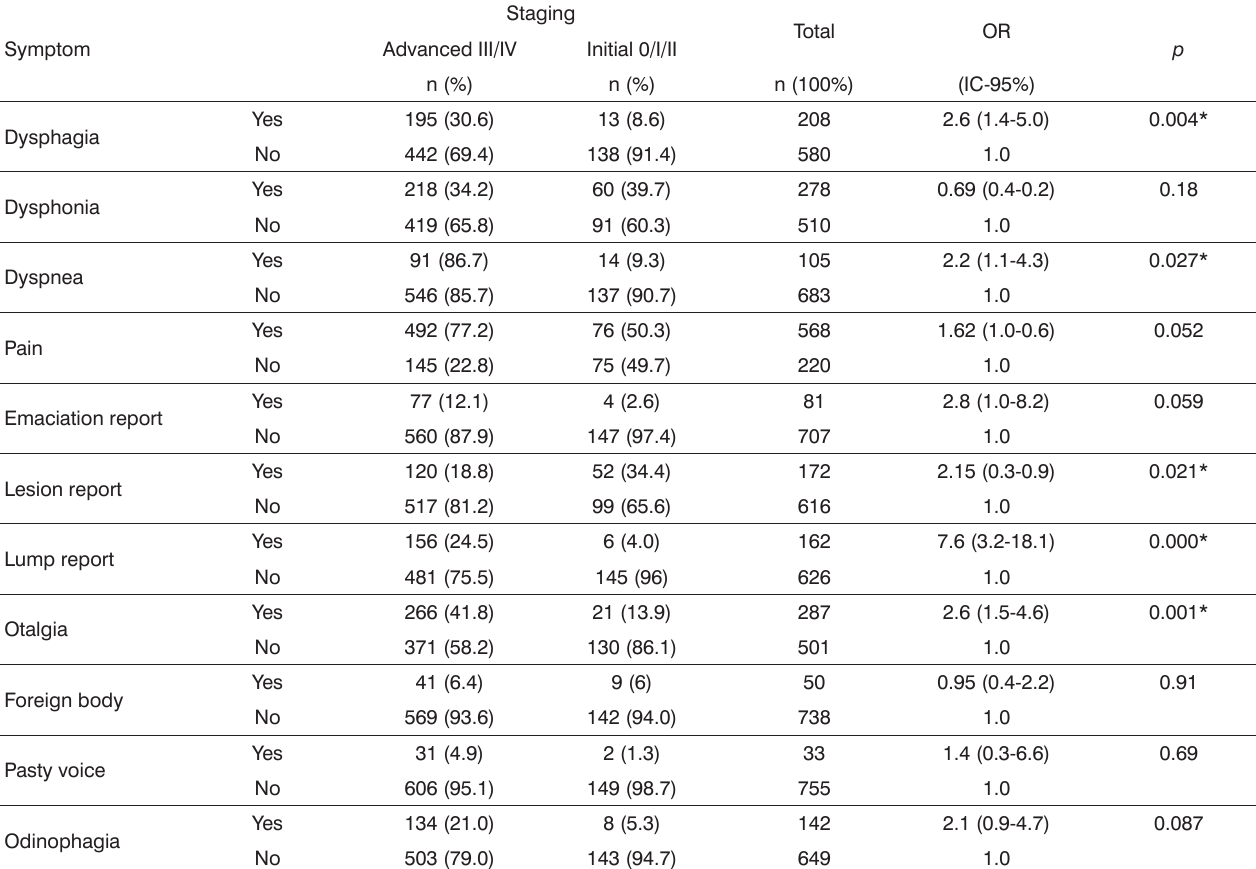
Table 3. Distribution of variables: symptoms of patients with UADT SCC, according to staging. Odds Ratio (OR - odds ratio) with a confidence interval of 95% (CI).